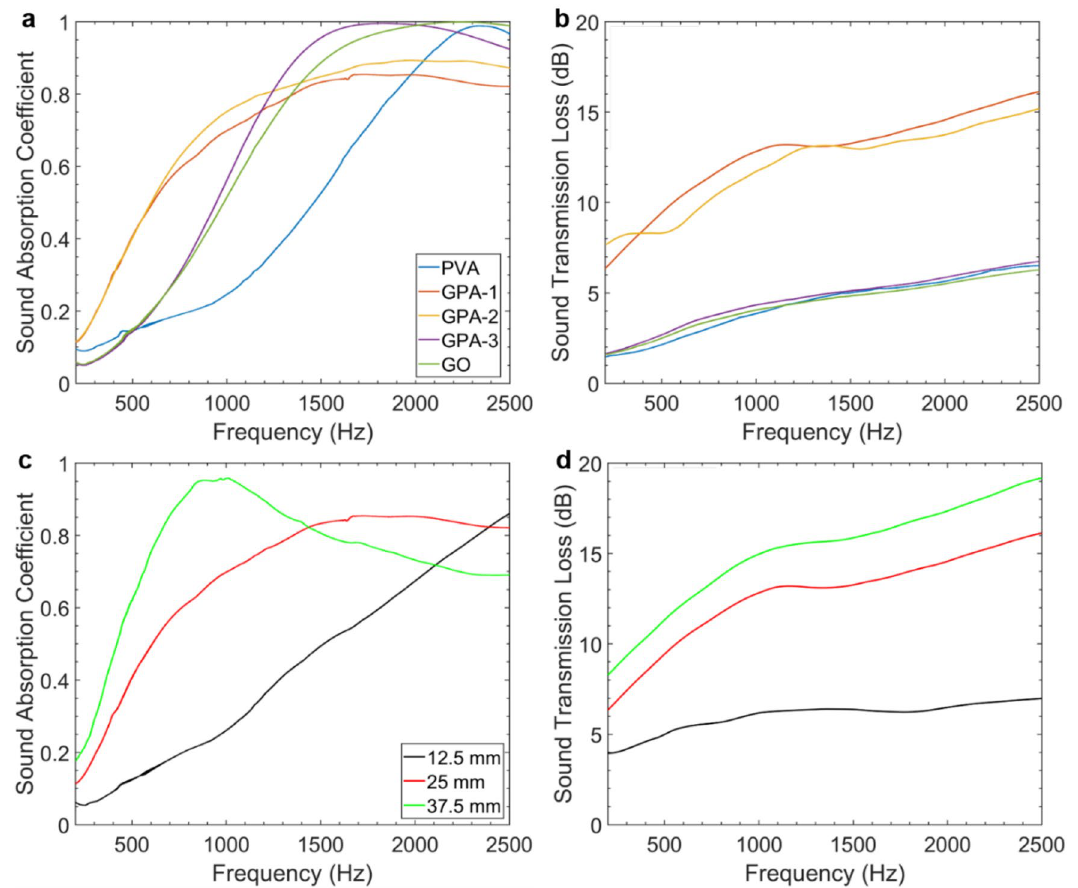
Figure 4. Effects of ( a , b ) GPA composition and ( c , d ) GPA-1 thickness on acoustic properties: ( a , c ) sound absorption and ( b , d ) sound transmission loss. Sample thickness is 25 mm when not studied as a variation ( a , b ). Key and average α and STL values are summarised in Tables S2 and S3.